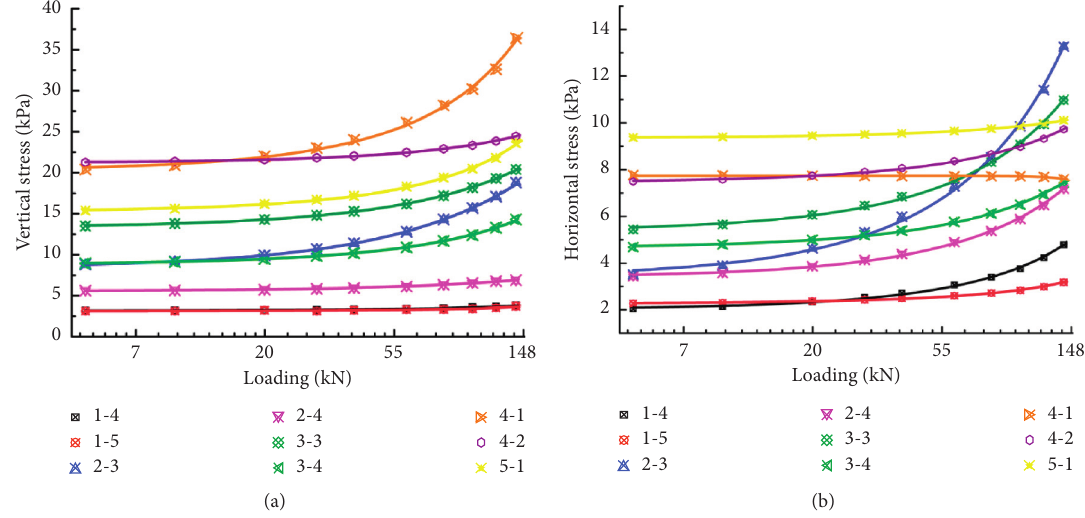
Figure 7: Relationship between the qualified stresses and loading in the transfer zone. (a) Vertical stress. (b) Horizontal